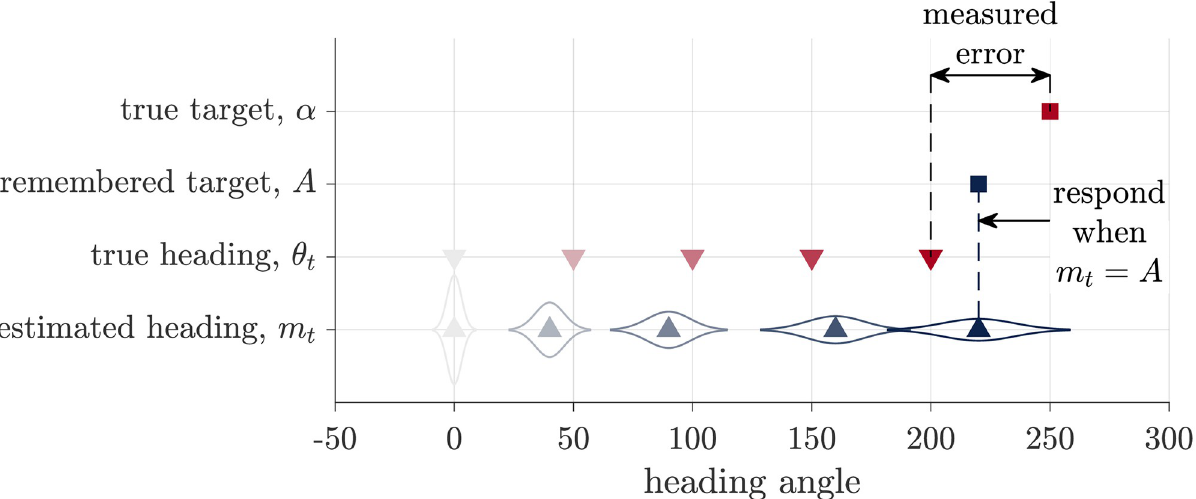
Fig 2. Schematic of the Path Integration model. During path integration, participants keep track of a probability distribution over their heading, which is centered at mean m t . To respond they compare this estimated heading to their remembered target location, A , halting their turn when m t = A . The experimenter observers neither of these variables, instead we quantify the measured error as the difference between the true target angle, α , and the true heading angle, θ t